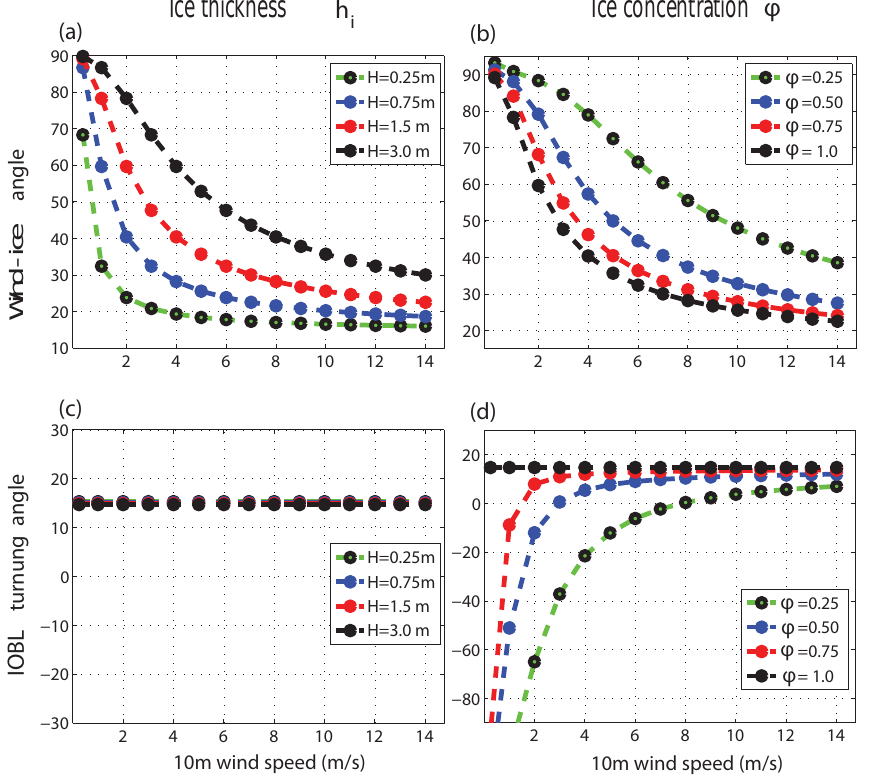
Figure 6. Sensitivity of (a, b) the wind–ice velocity angle and (c, d) the IOBL turning angle to various values of (a, c) sea ice thickness h i (m) and (b, d) sea ice concentration ( ϕ ) as a function of 10m wind speed (abscissa; ms − 1 ). In all panels the dimensionless vertical diffusivity is fixed at K ∗ o = 0.028. In (a, c) we use 100% sea ice concentration ( ϕ = 1), and in (b, d) we use a sea ice thickness of h i = 1.5m.